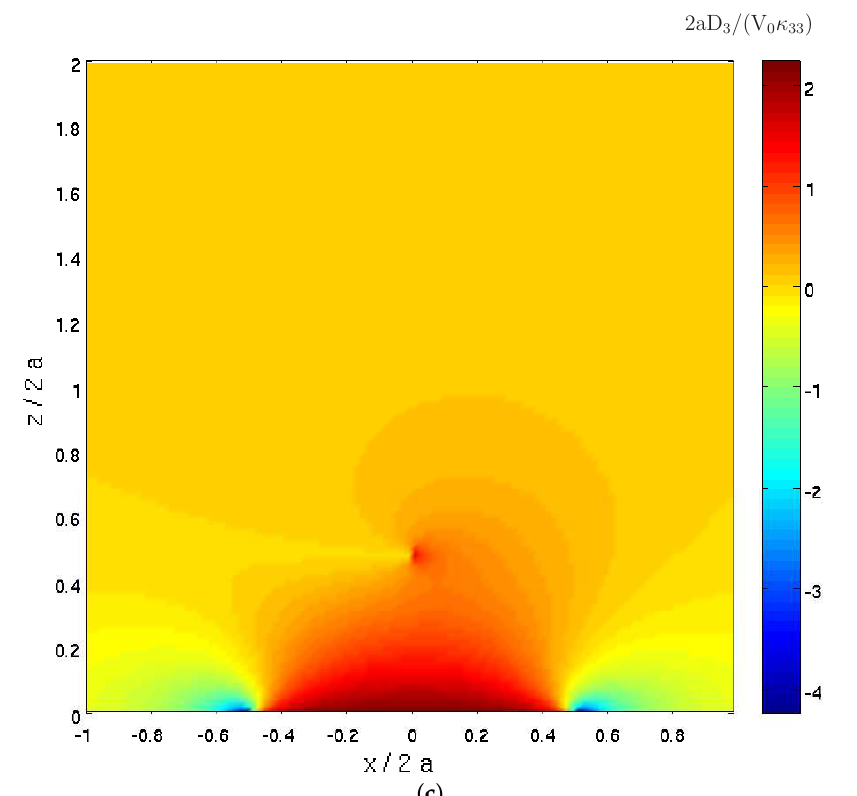
Figure 5. A piezoelectric (PZT-7A) half-plane attached to an electrode of electric potential V 0 at z = 0 with a defect in the form of a semi-infinite (long) crack. ( a ) The variations of the induced normal stress σ 33 and electric displacement D 3 along the crack line at z / a = 1. ( b ) The distribution of the induced normal stress σ 33 in the region − 1 ≤ x /2 a ≤ 1, z /2 a ≤ 2. ( c ) The distribution of the normal electric displacement D 3 in the region − 1 ≤ x /2 a ≤ 1, z /2 a ≤